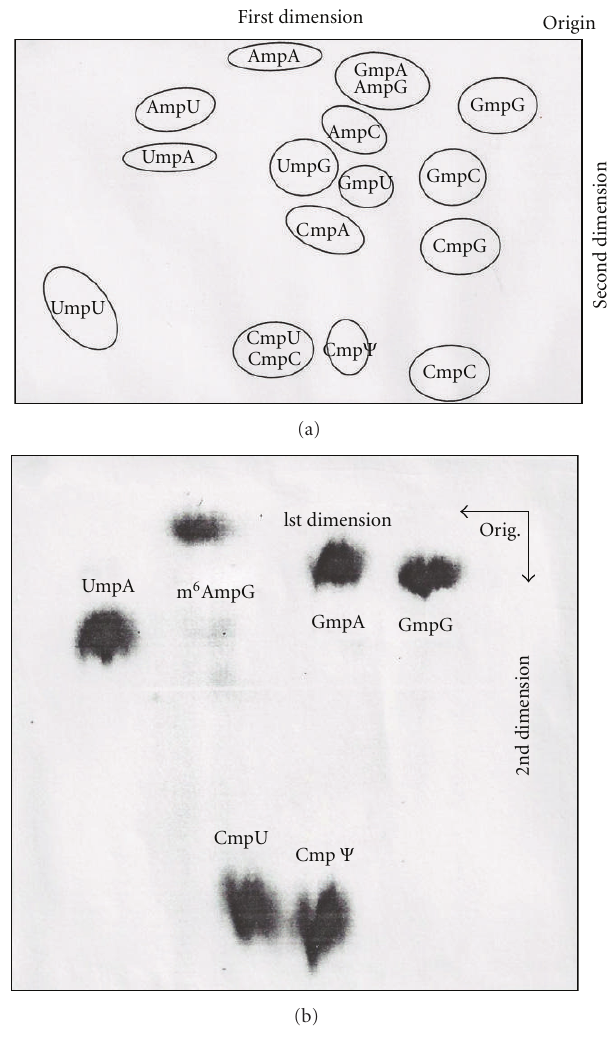
Figure 16: Two-dimensional separation of alkali stable dinucleo- side monophosphate [18, 39]. (a) Standard dinucleoside mono- phosphates (NmpN) were separated on Whatman no.1 paper with the solvent systems ethylacetate-1-propanol-water (4: 1:2, v/v) in the first dimension and in the second dimension with 2-propanol- water-concentrated ammonium hydroxide (7:2:1, V/V). (b) Auto- radiograph of two-dimensional separation of alkali-stable dinucle- oside monophosphate of U2 RNA from Noviko ff hepatoma cell nuclei. The [ 32 P]-labeled U2 RNA was hydrolyzed by 0.3N NaOH, and the sample was separated on a DEAE-Sephadex column A-25 at pH 7.6. The dinucleotides were collected and treated with alkaline phosphatase. The alkali stable dinucleoside monophosphates were separated on Whatman no. 1 paper and autoradiographed with X- ray film.